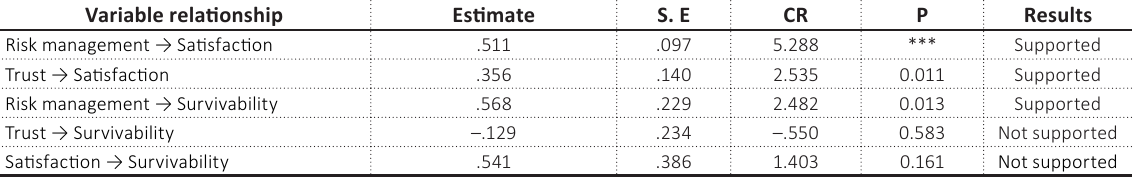
Table 3. Research